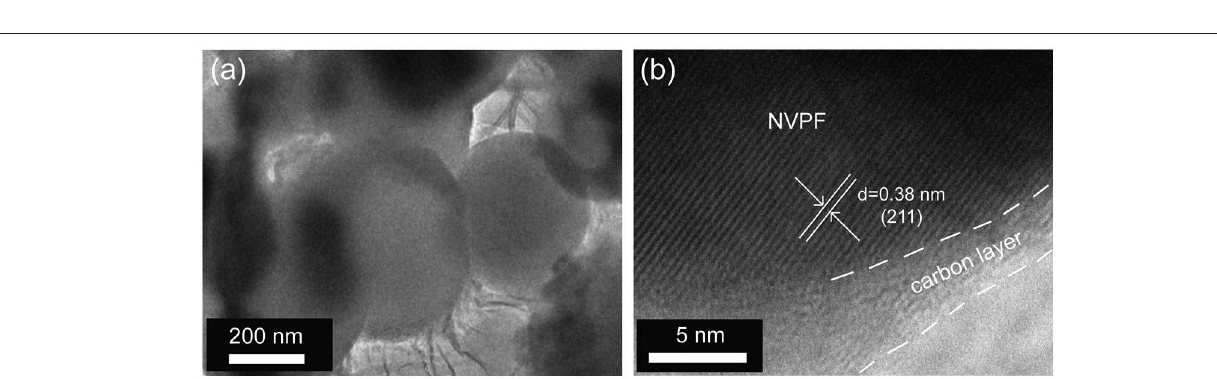
FIGURE 4 | (a) Low- and (b) high-resolution TEM images of NVPF/C/rGO.